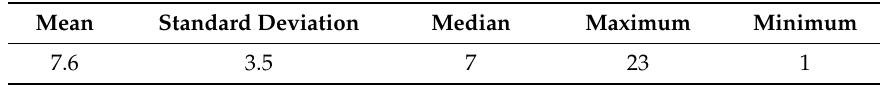
Table 1. Basic statistics of the daily number of deaths from respiratory disease for persons aged 65 or older at time of death from 2008 to 2017 in Seoul,